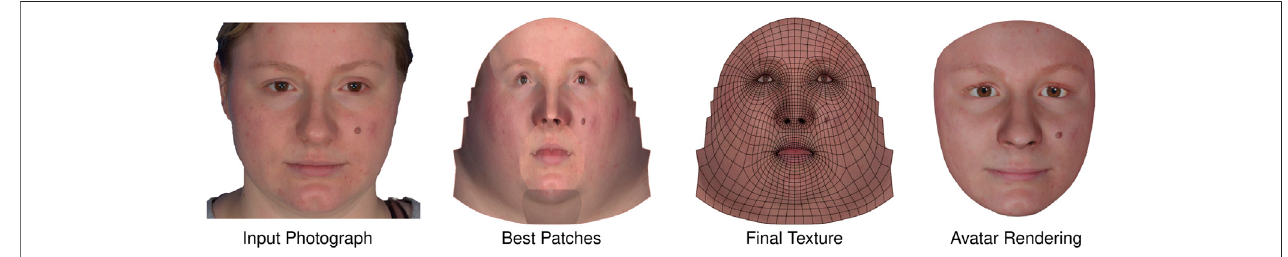
FIGURE 5 | Individualized avatar automatically reconstructed from several photographs. After merging of patches, the photographic texture is nonrigidly aligned with the template to accurately match the outlines of facial